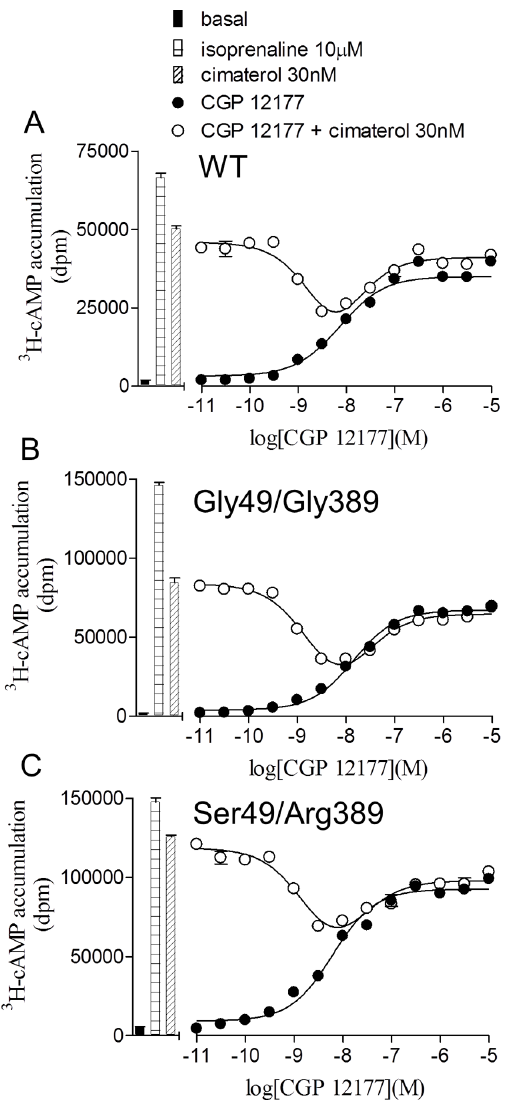
Figure 4. Demonstration of two agonist conformations of the wildtype b 1-adrenoceptor and polymorphic variants. 3 H-cAMP accumulation in response to CGP 12177 in A wildtype cells, B Gly49/ Gly389 cells and C Ser49/Arg389 cells in the absence and presence of 30 nM cimaterol. Bars represent basal 3 H-cAMP accumulation, that in response to 10 m M isoprenaline and that in response to 30 nM cimaterol. Data points are mean 6 s.e.mean of triplicate determinations and these single experiments are representative of 5 separate experiments in each case. Low concentrations of CGP 12177 inhibit the high affinity catecholamine conformation and higher concentra- tions of CGP 12177 stimulate an agonist response. This demonstrates the two agonist conformations of the wildtype b 1-adrenoceptor and that both of these agonist conformations are present in both polymorphic